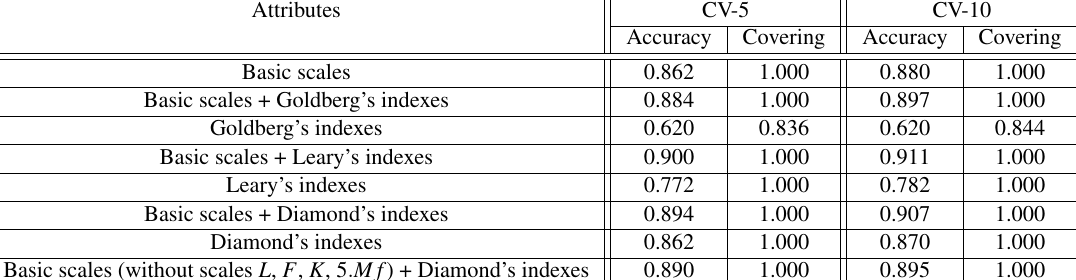
Table 6: Results of experiments using the genetic